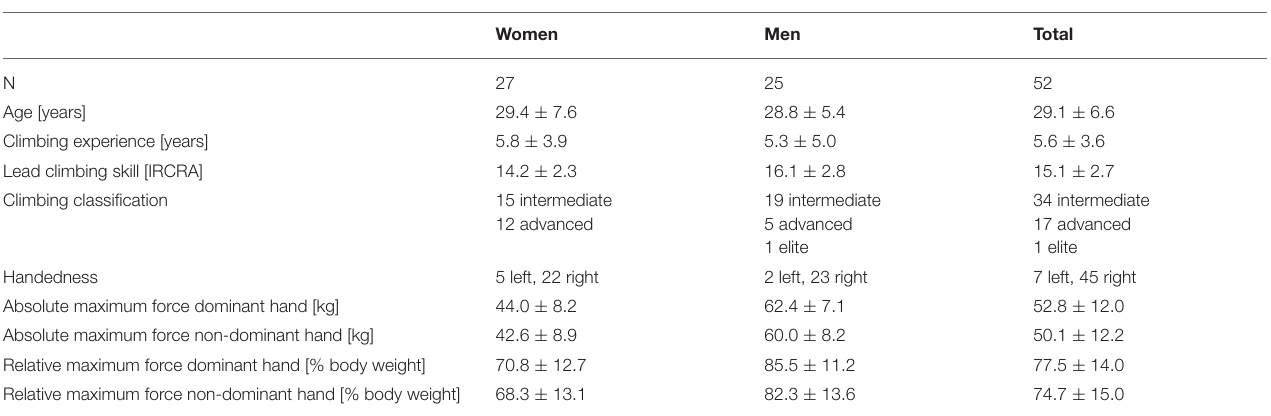
TABLE 3 | Participant